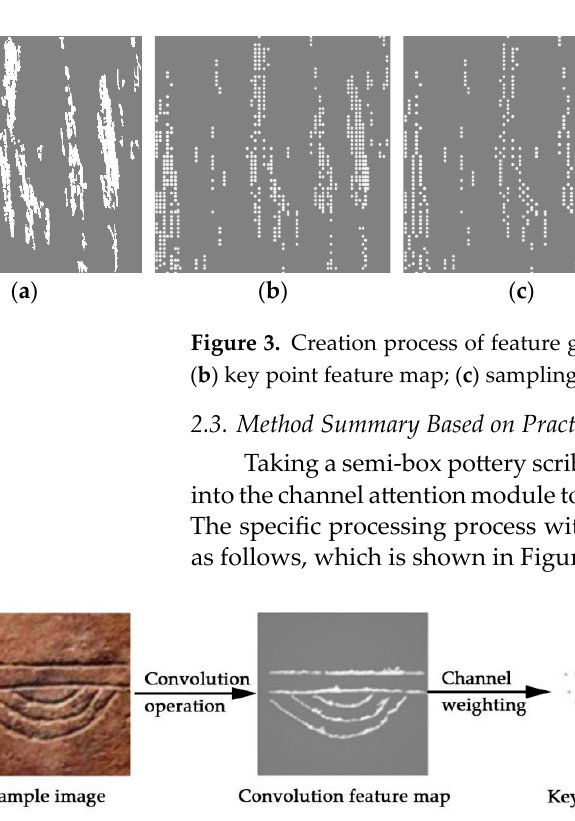
Figure 4. Feature graphic generation process by deep learning